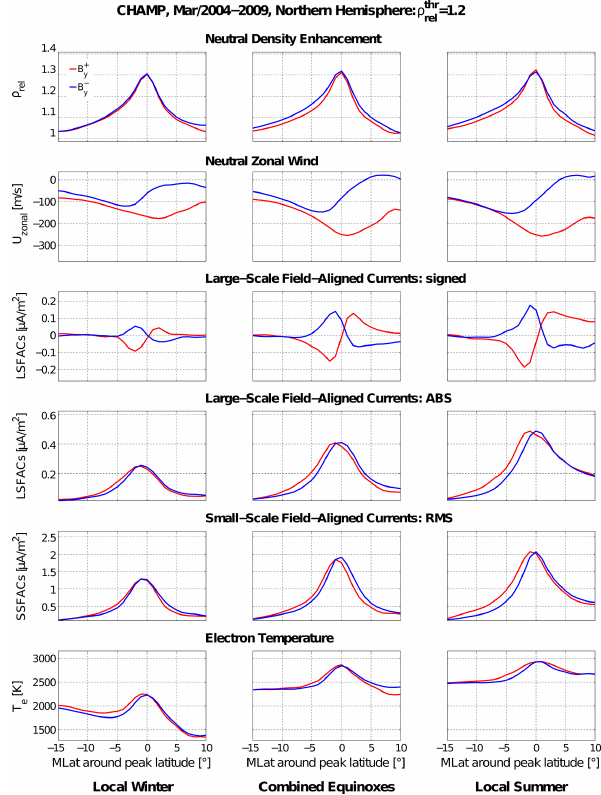
Fig. 3. The same as Fig. 1 but for the period March 2004–March